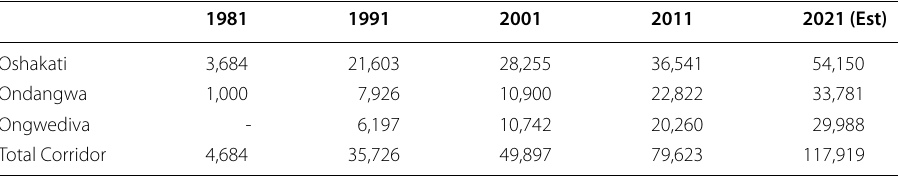
Table 1 Urbanization in Namibia,